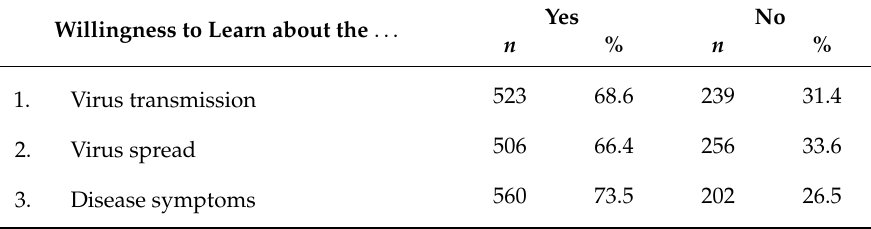
Table 4. Interest to obtain information on SARS-COV-2 and COVID-19. Willingness to Learn about the